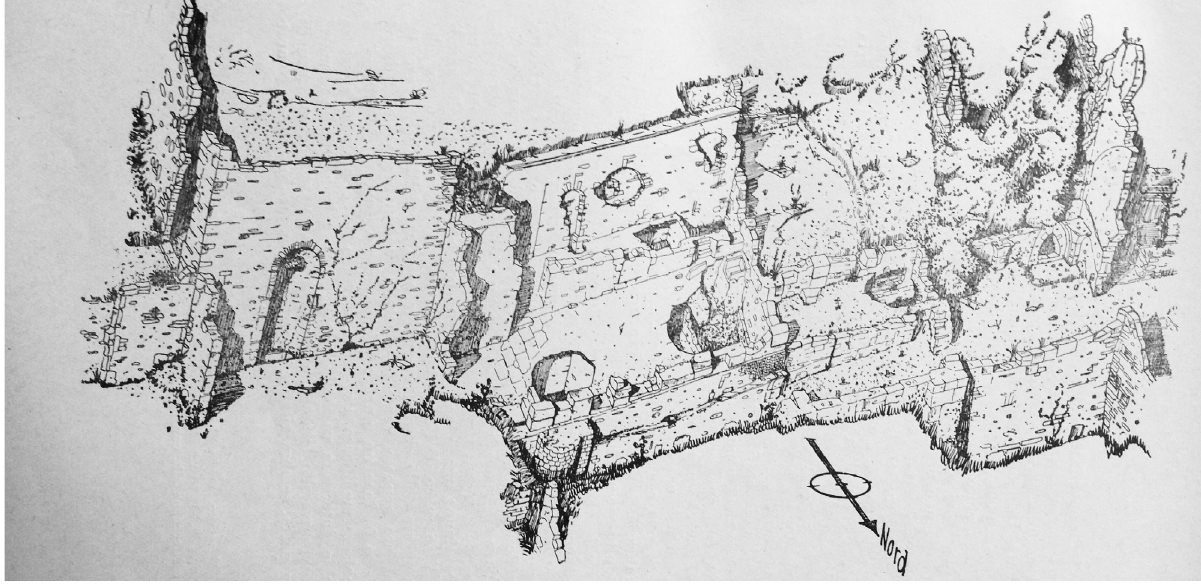
Figure 4. Axonometric view of San